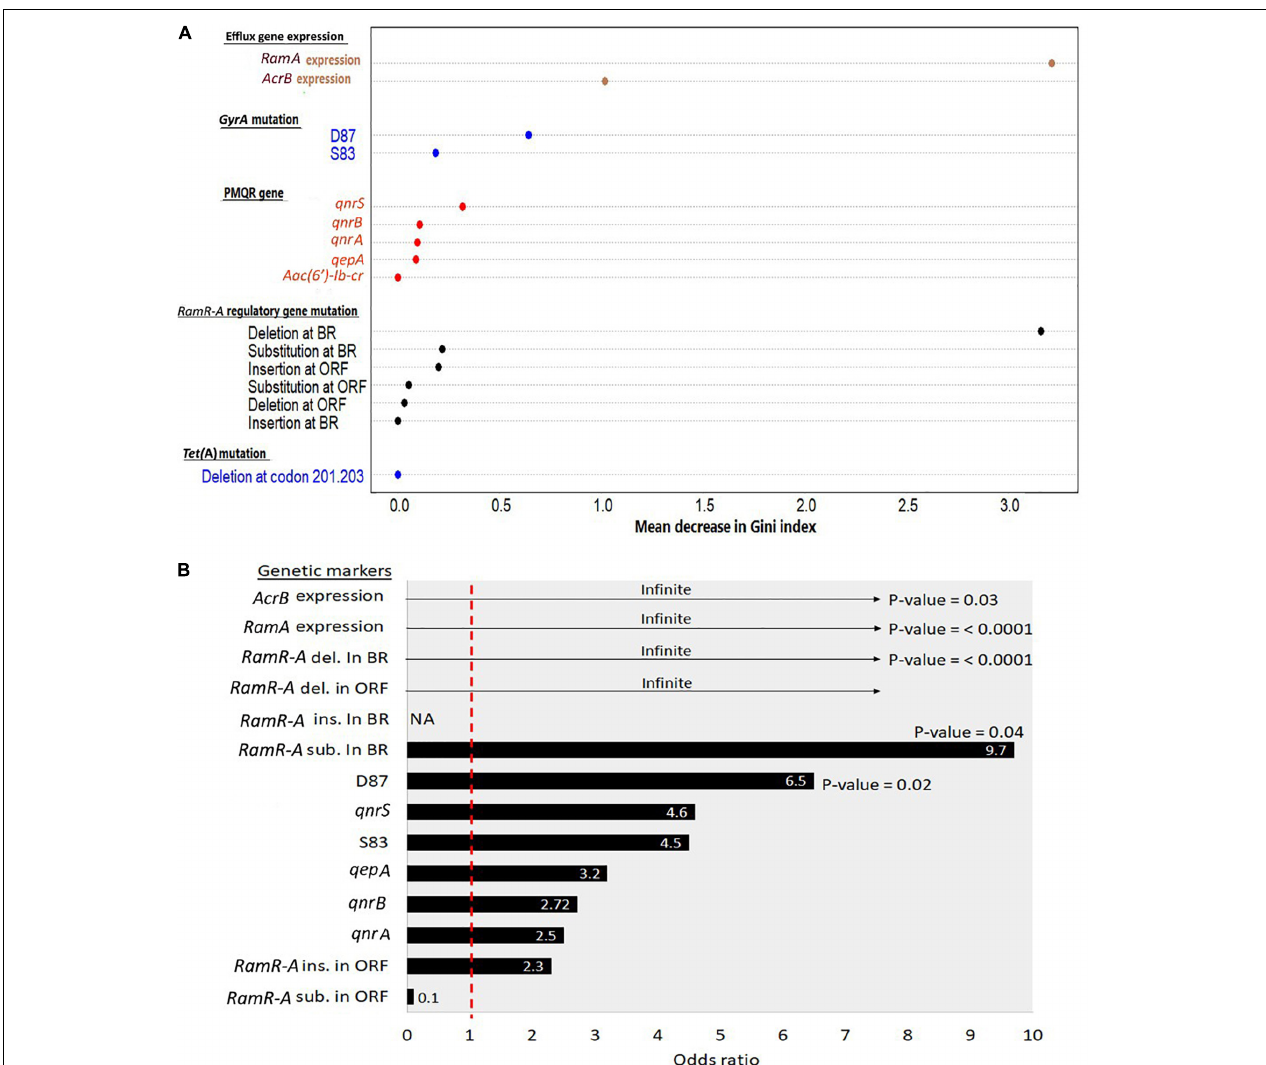
FIGURE 2 | Ranked significance of genetic markers in the XDR Salmonella isolates that showed co-resistance to ciprofloxacin and tigecycline ( n = 25). (A) Random forest classification analyses showing the importance of genetic markers in differentiating the co-resistant XDR Salmonella isolates from those that were resistant to CIP only ( n = 4). The X -axis shows the mean decrease in Gini index for each marker. The higher the mean decrease in the Gini index, the more important the marker. (B) Significance of association of genetic markers and the co-resistance phenotype. The X -axis shows the odds ratio (at confidence intervals = 95%) of the respective genetic features that are shown on the Y -axis. Numbers within the bars refer to odds value. Numbers beneath the bars show the significance of association ( p- value based on Fisher’s exact test at a cutoff level of 0.05) between the occurrence of certain genetic features and the appearance of the co-resistance to CIP and TIG in the 25 XDR isolates. The odds ratios that were shown as headed arrow indicate an infinite ( ∞ ) or maximum odds. The odds ratio of 1 (the vertical dashed red line) indicates no contribution of the respective genetic feature to the occurrence of the co-resistant phenotype. Del, deletion; Sub, substitution; Ins, insertion; BR, binding region; ORF, open reading